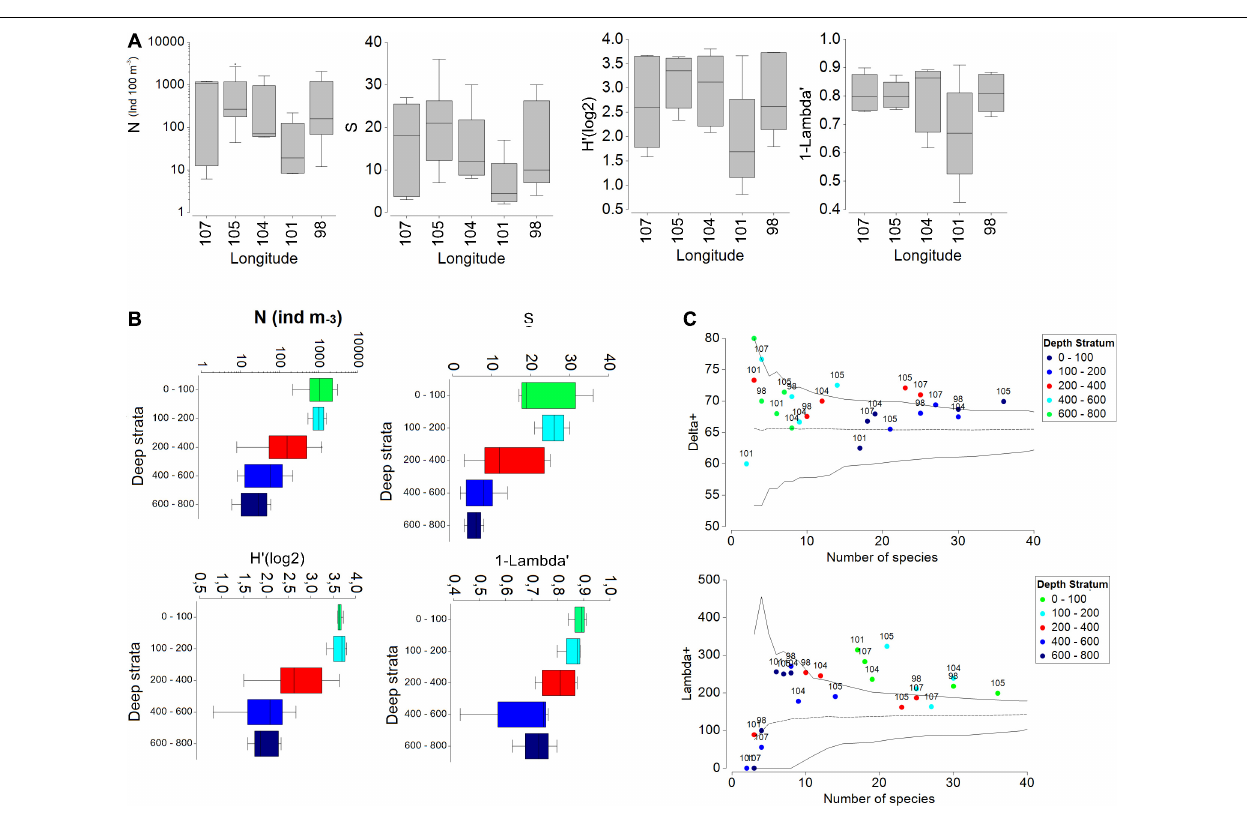
the region, albeit with high variability. The taxonomic distinction index (delta + ) had an expected mean of 65, and the expected taxonomic distinction variation (lambda + ) had a value of 100